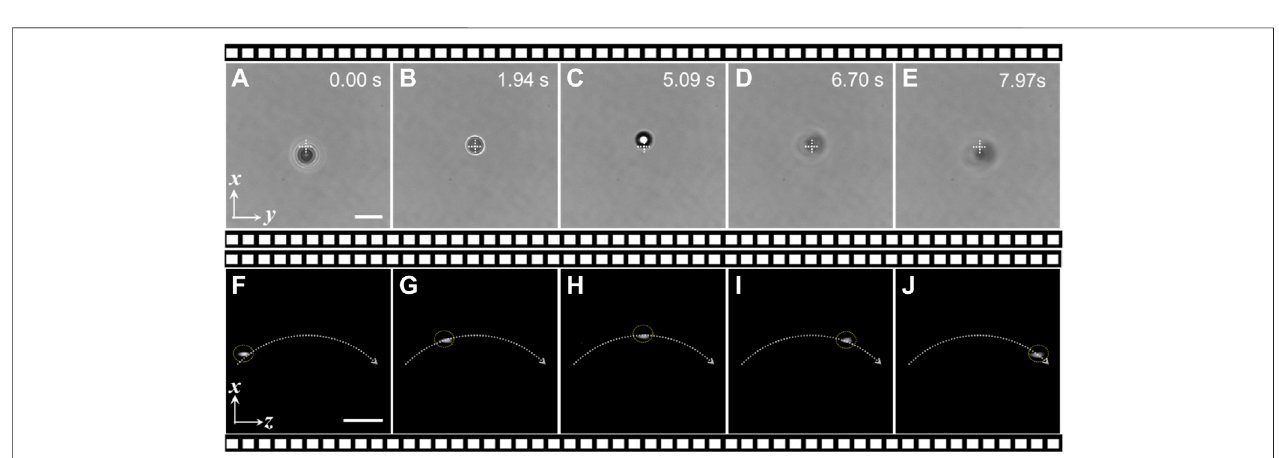
FIGURE 3 | Experimental observation results of particle transporting dynamics along the Weber beam trajectory. (A – E) The lateral ( x-y ) plane images of a trapped particle at different time; (F – J) the axial ( x-z ) plane images corresponding to (A – E) . Particles: polystyrene beads of 5 µm in diameter. Scale bar: 10 µm.